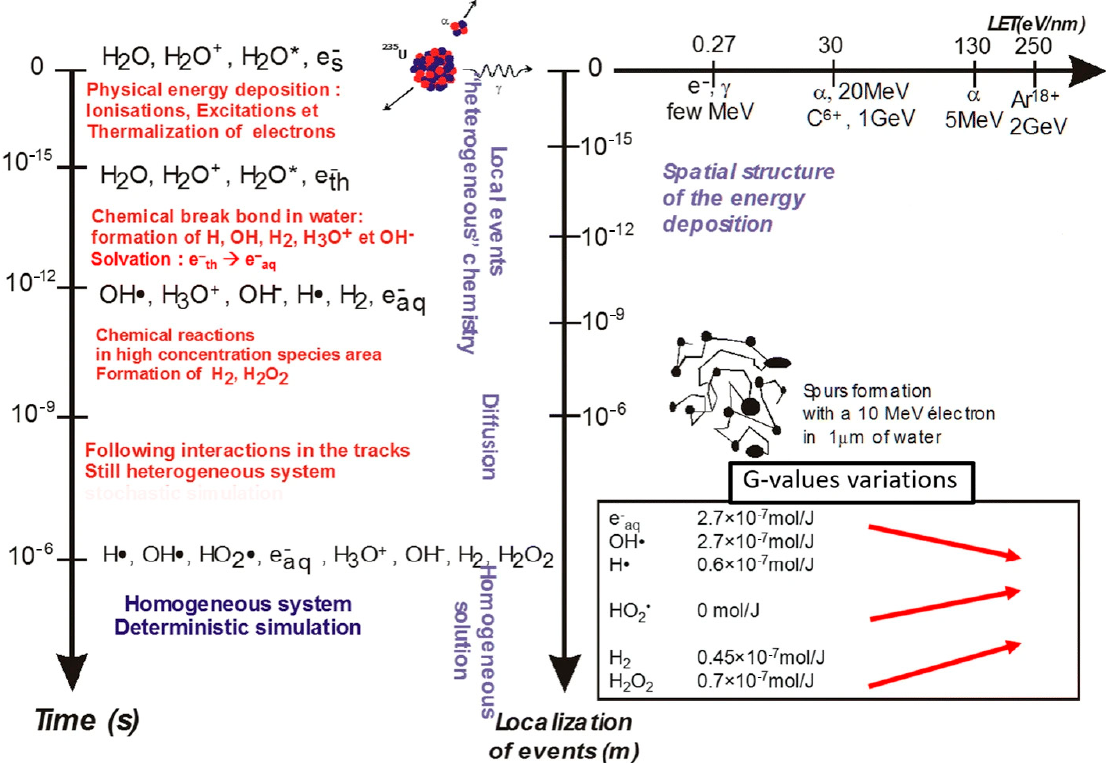
Figure 3. Representation of the reactions of transient species produced by irradiation in pure water. Time is represented on the vertical left axis, localizations in space on the central vertical axis, and LET on the horizontal axis of the right scheme. The values of primary radiolytic yields ( G -values) are tabulated and shown with respect to the LET axis (from the lowest LET to the highest one). Red arrows indicate the typical variations in the G -values when LET increases. (Adapted with permission from reference [78]). H 2 O* represents excited